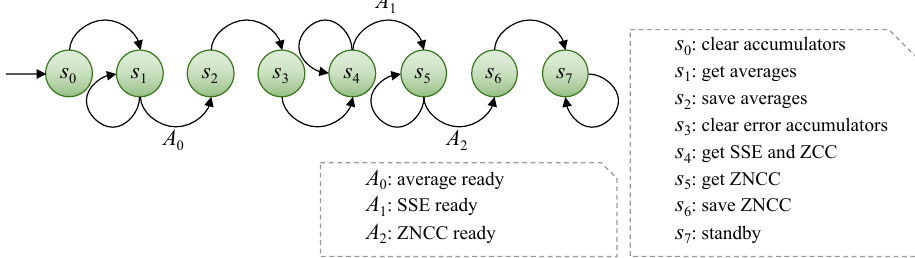
Figure 4. A visualization of the Moore machine of the ZNCC CU. This CU supervises the custom ZNCC module’s proper functioning. It has control over another CU that manages accumulation and datapath elemental blocks.